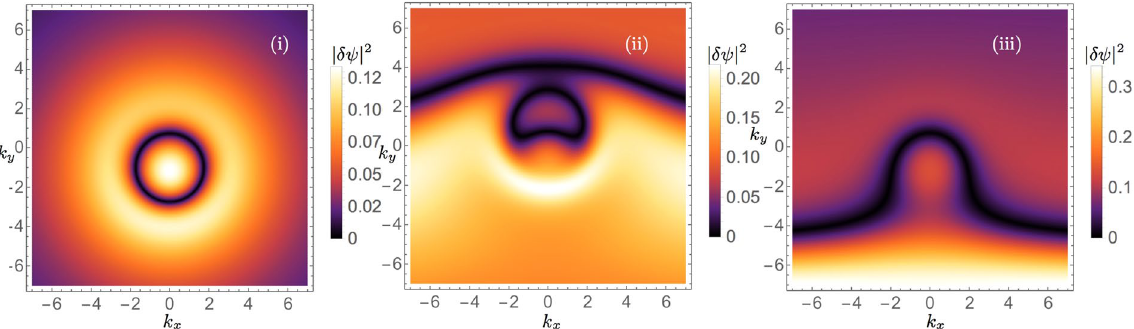
Figure 3. Linear wave functions | δψ ( k x , k y )| of the lower polariton branch for the parabolic ( i ), the m ( k ) model ( ii ) and the general kinetic energy ( iii ) showing the structural differences of the predictions of the three kinetic energy models. The direction of motion is in − k y direction and the specific parameters corresponding to the figures are set as follows. =  ⁎ bP 1 , P = 1, v x = 0, v y = − 1, I . Further we subtract ω L (0) from the dispersions for better